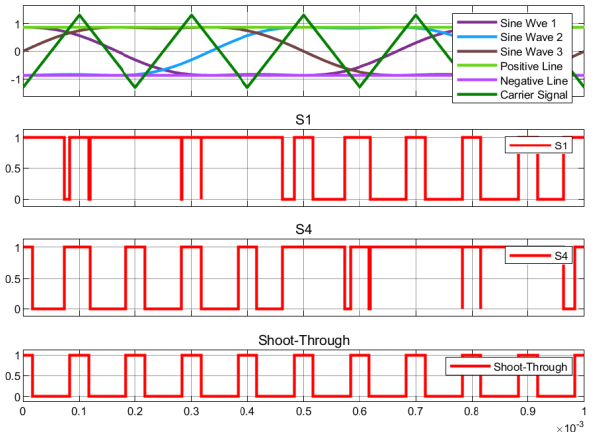
Figure 5. MCBC-3rd harmonic injection modulation technique.